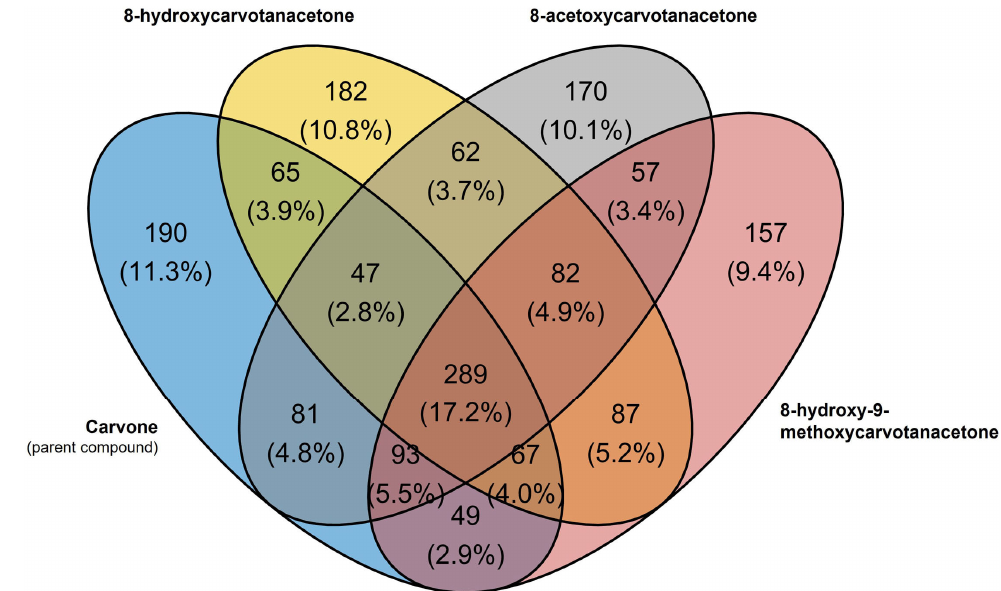
Figure 8. Venn diagram of the predicted targets (rank > 90) of carvone and three of its derivatives tested in vitro , according to the DTI prediction model.